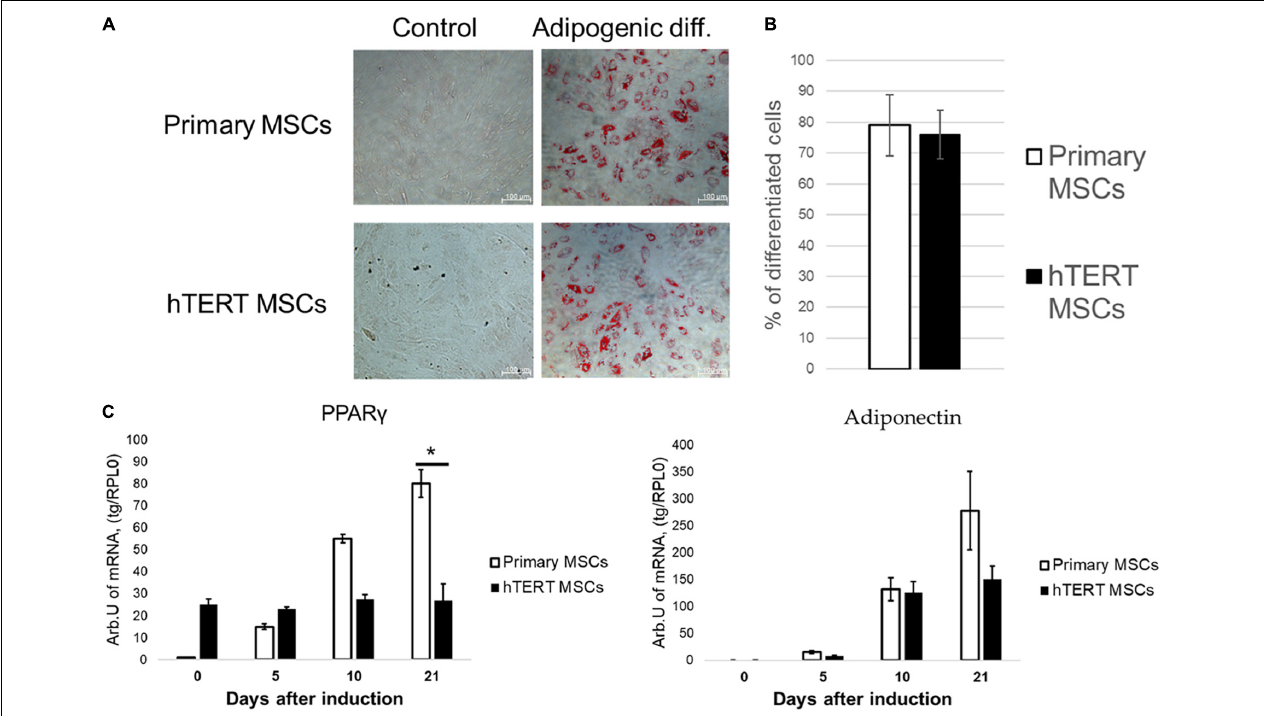
FIGURE 4 | Indomethacin reduces differences in adipogenic potential between human adipose-derived primary MSCs and hTERT-MSCs. MSC differentiated into adipocytes (Oil Red O staining, “Adipogenic diff.”) under inductive conditions in the presence of indomethacin. Group “control” related to the cells cultured in standard conditions without differentiation induction. (A) Representative images, phase-contrast microscopy. (B) Relative efficiency of adipogenic differentiation of primary MSCs and hTERT-MSCs. (C) Temporal dynamic of marker gene expression during differentiation in MSCs and hTERT-MSC. Results are presented as